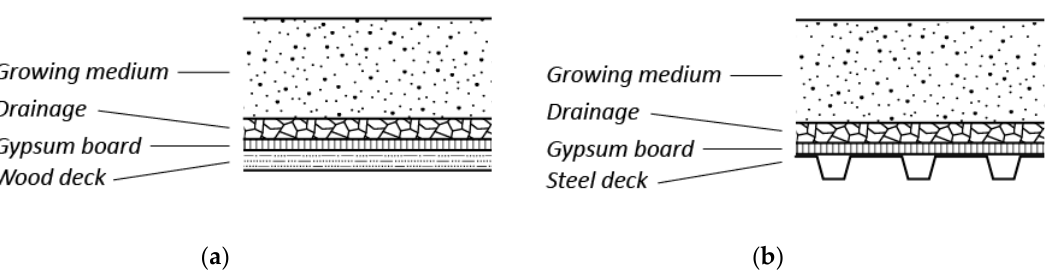
Figure 1. Assemblies with the gypsum board installed over a: ( a ) Wood deck; ( b ) steel deck.